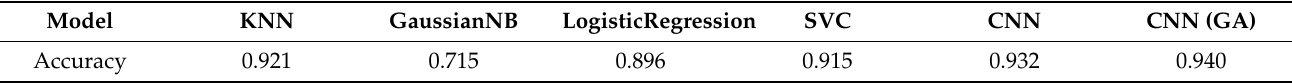
Table 6. Comparison of recognition accuracy of multiple models.